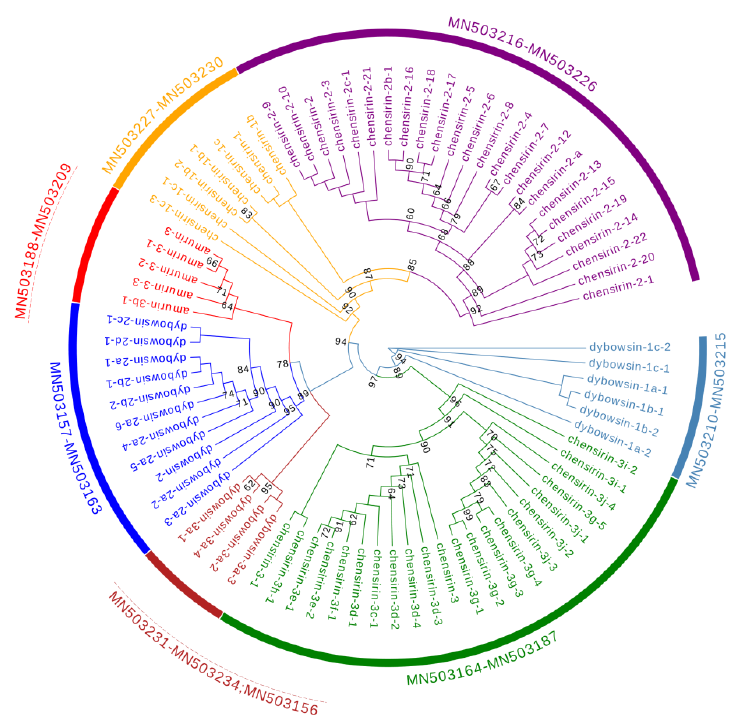
Figure 2. A phylogenetic tree of antimicrobial peptide (AMP) genes identified from R. dybowskii . The tree was constructed based on the sequence of acidic propiece and mature peptide region. Numbers in the figure are confidence values with bootstrap 1000 replicates; only values ≥60 are shown.